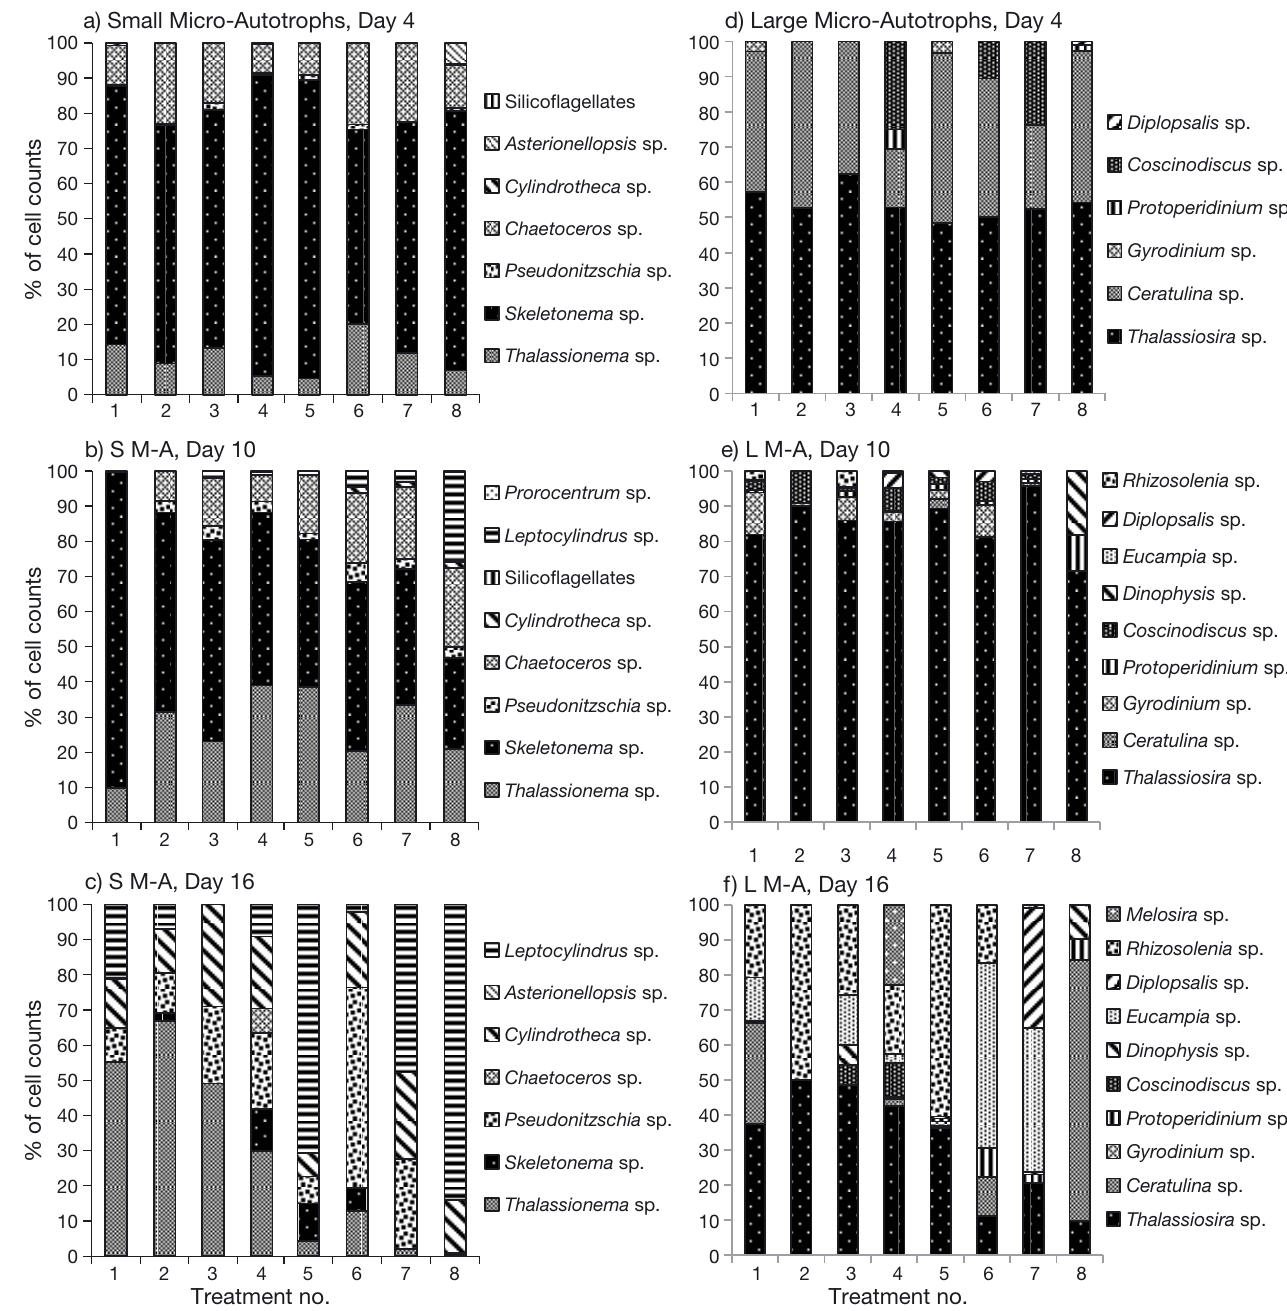
Fig. 7. Percent composition of the small and large micro-autotroph communities on (a,d) Day 4, (b,e) Day 10, and (c,f) Day mesocosms, reaching a maximum cell number on come dominant in cell numbers towards the end mesocosms (T1–T3) and on Day Day 16 in the low L of the experiment. N mesocosms (T4–T8) before a rapid 10 in the high L The small micro-autotroph fraction was initially N mesocosms, the decline to Day 16. In the high L dominated by Skeletonema sp. (95% of counts), N number of Lepto cylindrus sp. increased from very whereas Skeletonema constituted 55−85%, Chaeto- low numbers to 2000−8000 cells ml −1 between ceros sp. 10−20%, and Thalassionema sp. 5−20% on Days 10 and 16. Also, Cylindrotheca sp. and Pseudo - Day 4 (Fig. 7a). On Day 10, Skeletonema sp. consti- tuted 25−90% of the cells, with numbers forming a nitzschia sp. increased from very low numbers to be-